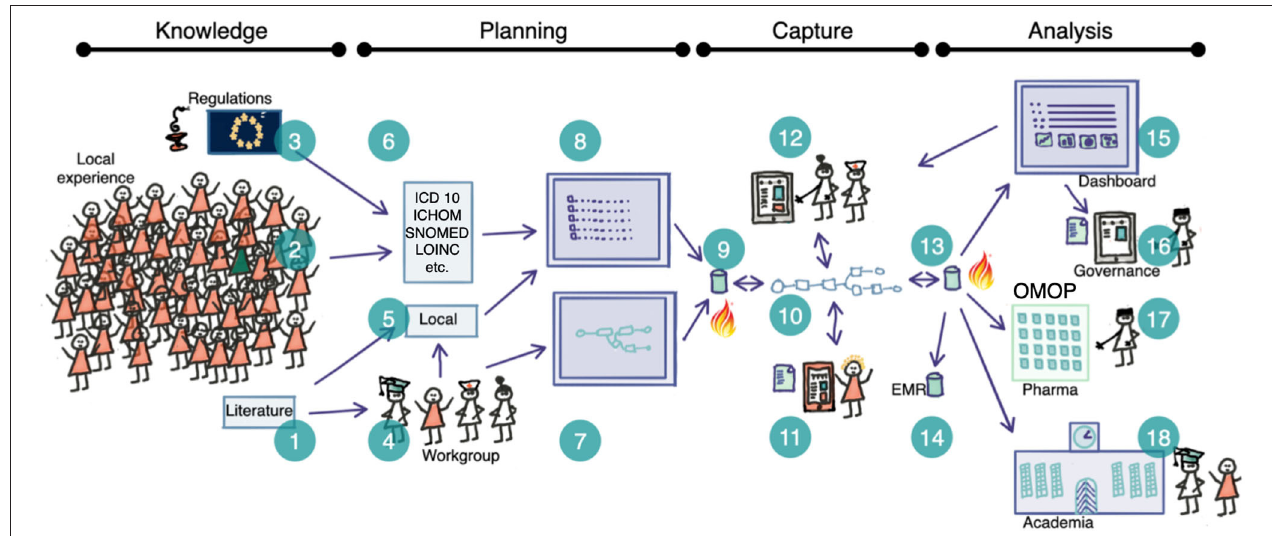
FIGURE 1 | Schematic overview of the planning-capture-analysis steps where semantically competent care plans are used as a basis for clinical operational interoperability The idea is based on the ability to capture structured data where the full semantic depth is retained in all steps. Therefore we need complete standard meta-data that give the provenance of each term (1–3, 6) and the ability to add local terms (5). Clinical workgroups (4) create clinical pathways (7) that are populated with terms (8) and formatted into FHIR Plan Definitions and stored (9). Healthcare professionals and patients generate real-world data by documenting the routine execution of clinical processes at their local institution prompted according to the care plan (10) and collected by the clinical data capture tool (11, 12). All data are collected in the local database (13) and transferred to the EMR (14). The RWD functions allow for dashboarding (15) and feedback to care/patients as well as analysis by different stake holders including regulators, academia (18) and industry (17) (anonymised data).